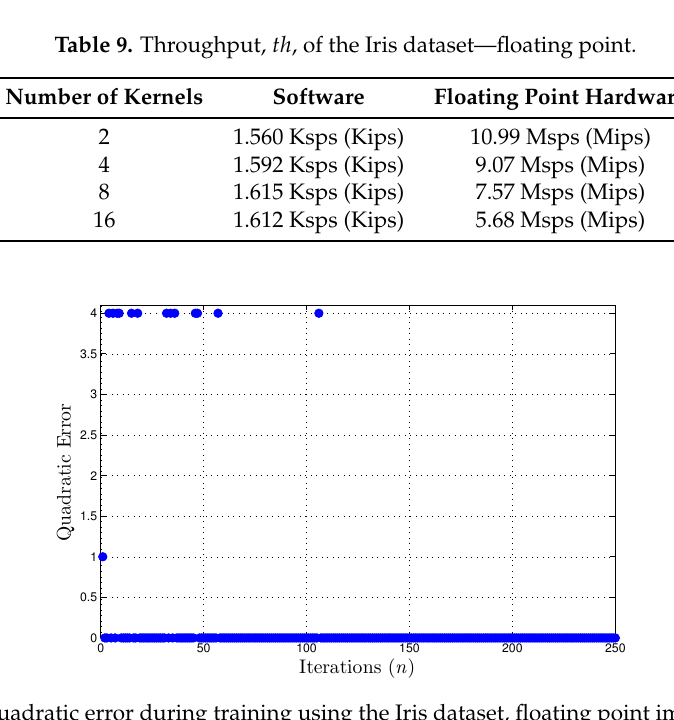
Figure 11. Quadratic error during training using the Iris dataset, floating point